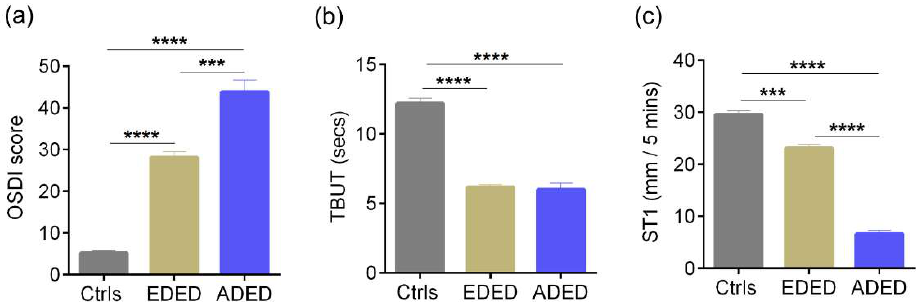
Figure 10. Ocular surface disease index score, Tear break up time, and Schirmer’s test values in subjects with dry eye disease. Bar graphs represent ( a ) Ocular surface disease index (OSDI) scores indicative of the discomfort/symptoms, ( b ) Tear break up time (TBUT) values in secs—indicative of sign and ( c ) Schirmer’s test (ST1) values in mm/5 min—indicative of sign in controls and in subjects with evaporative dry eye disease (EDED) or aqueous deficient dry eye disease (ADED). Controls are subjects without discomfort/symptoms and signs (D - S - ). Controls (Ctrls): n = 58 eyes; EDED: n = 147 eyes; ADED: n = 48 eyes. *** p < 0.001, **** p < 0.0001, Kruskal–Wallis test with